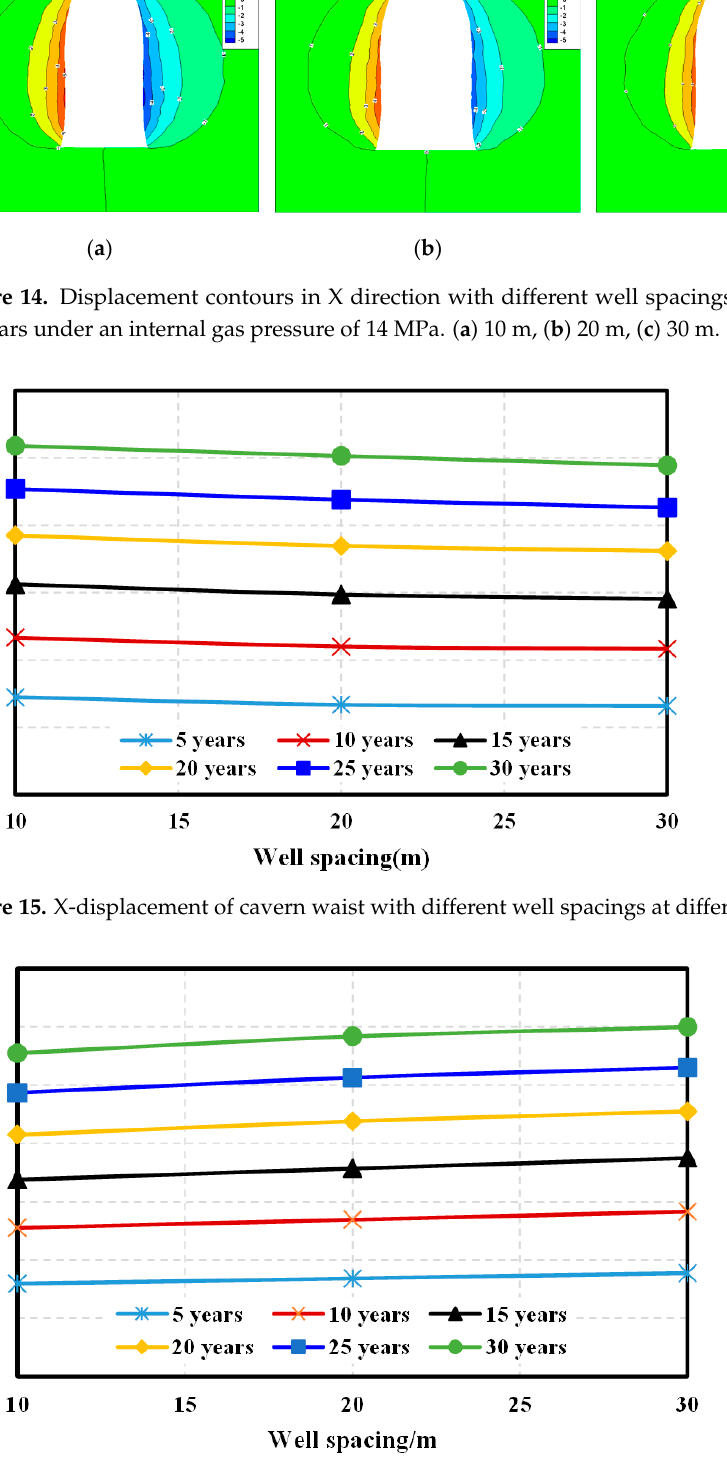
Figure 16. Y ‐ displacement of cavern waist with different well spacings at different operating times.